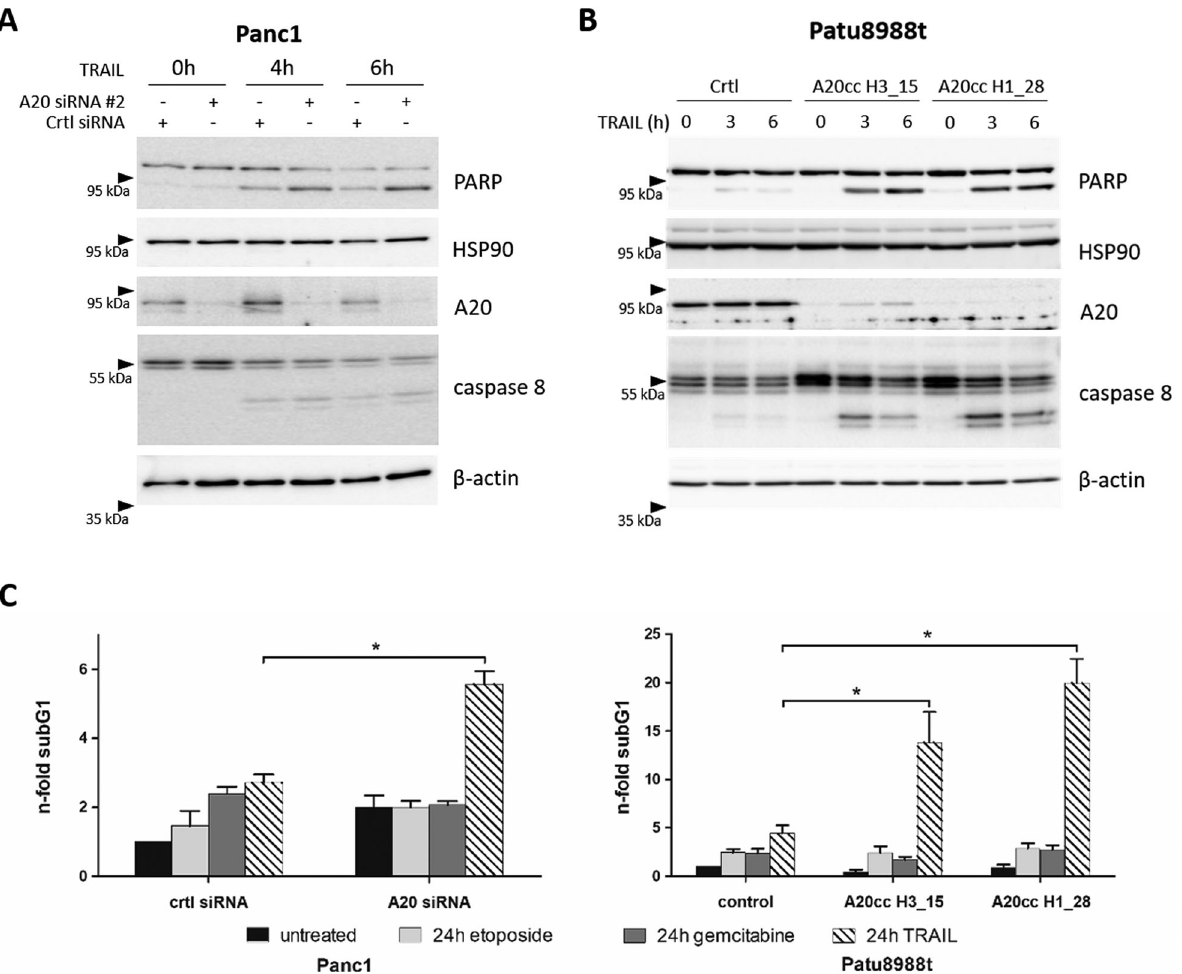
Fig. 5 A20 mediates chemoresistance towards TRAIL in PDAC cells. SiRNA-treated Panc1 cells (left panel) or Patu A20cc (right panel) were treated with therapeutic drugs (20 µg/ml etoposide, 10 µg/ml gemcitabine, or 100 ng/ml TRAIL) for indicated periods. A , B whole-cell lysates were conducted to western blot analysis with indicated antibodies and HSP90 and β -actin as loading controls, n = 5. C Panc1 cells (left panel) and Patu8988t (right panel) were analyzed for apoptotic cell death by subG1 assay. Shown are results from 5 independent experiments, * p < 0.05, n = 5.